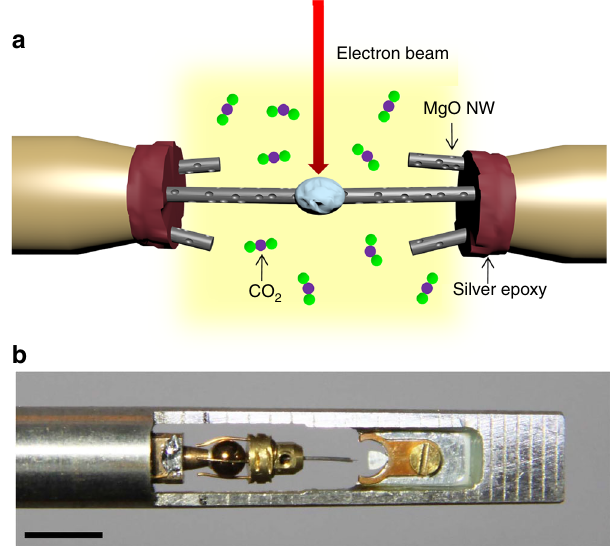
Fig. 1 Schematics of the ceramic nanowelding setup. a The experiment was carried out in an ETEM with an atmosphere of CO 2 . Prior to the experiment, several MgO nanowires were fi rst glued to two Al probes using silver epoxy, and then were manipulated to approach each other using a STM holder. b The real image of the STM holder utilized in this study. Scare bar = 0.5